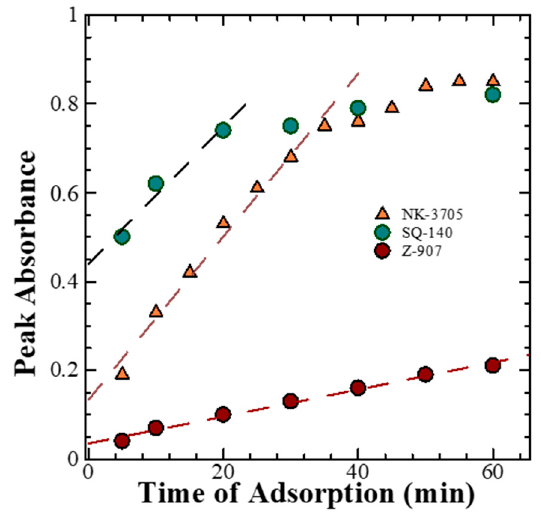
Figure 3. Rate of dye adsorption for NK-3705, Z-907, and SQ-140 on TiO 2 and the comparison of NK-3705, Z907, and SQ140 single-dye rate of adsorption.